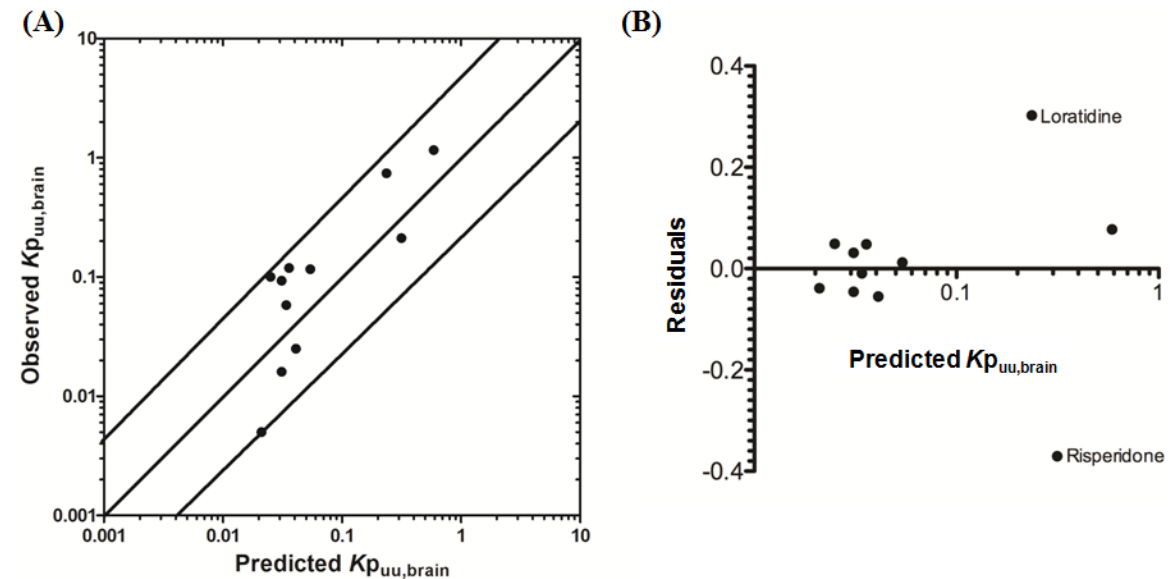
Figure 4. Comparison of predicted and reported K p mid-line represents the line of unity and solid outer-lines represent 4-fold prediction error; and ( B ) residuals